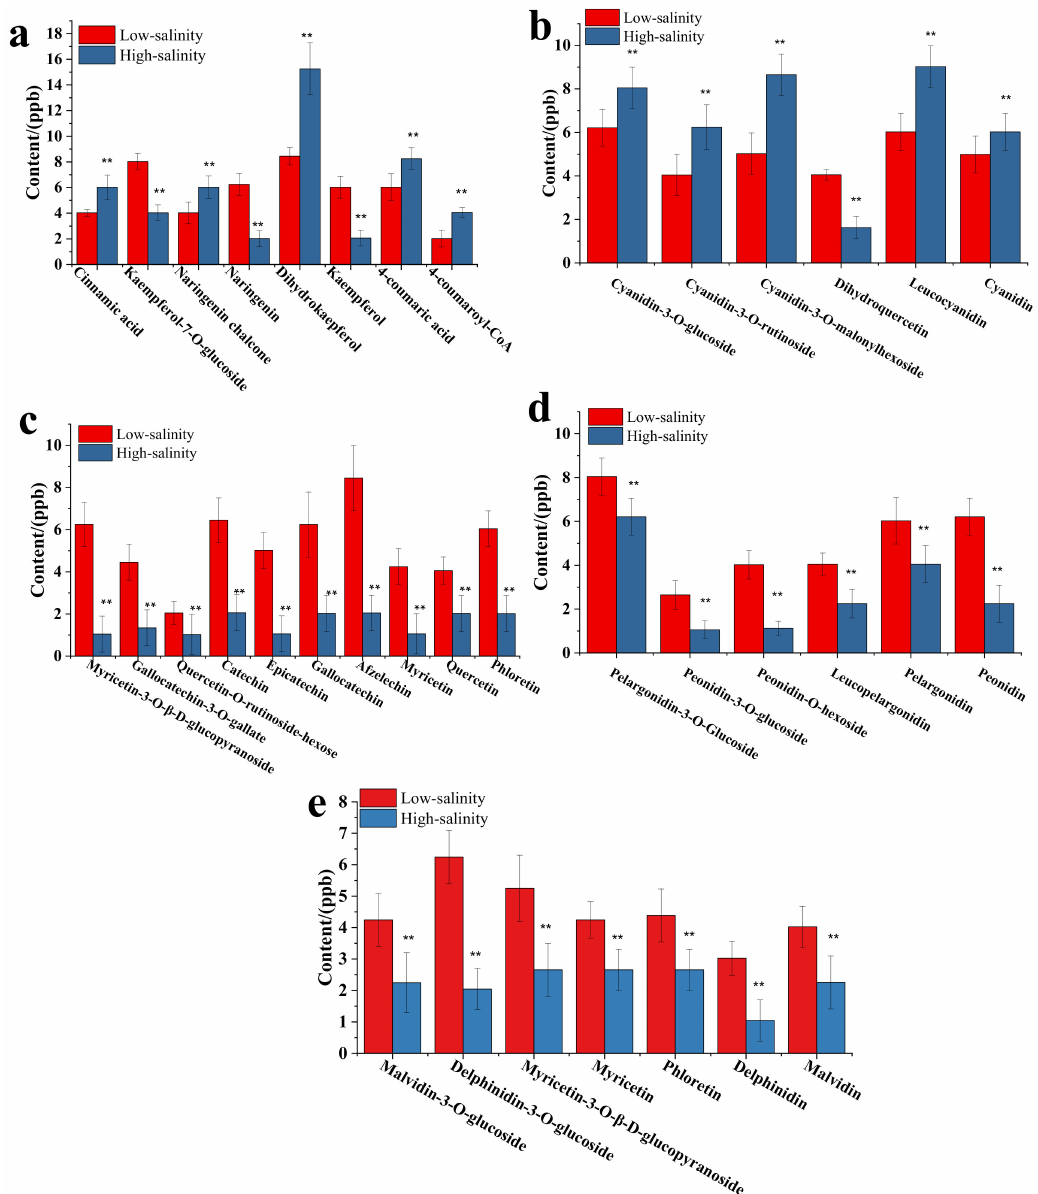
Figure 8. Effect of the salinity influence on polyphenols accumulation in low and high groups. ( a ) The salinity influences the accumulation of cinnamic acid, kaempferol-7-O-glucoside, naringenin chalcone, naringenin, dihydrokaempferol, kaempferol, 4-coumaric acid, and 4-coumaroyl-CoA; ( b ) The salinity influences the leucocyanidin, dihydroquercetin, cyanidin and its family ingredients. ( c ) The effect of salinity on the content of other anthocyanins. ( d ) The effect of salinity on the content of peonidin, pelargonidin, leucopelargonidin, peonidin and its family ingredients. ( e ) Effect of differential salinity on the content of Malvidin, delphinidin, phloretin, myricetin, myricetin-3-O- β -glucopyranosided and its glycoside compound. Datasets with the same letter do not significantly differ (** p <